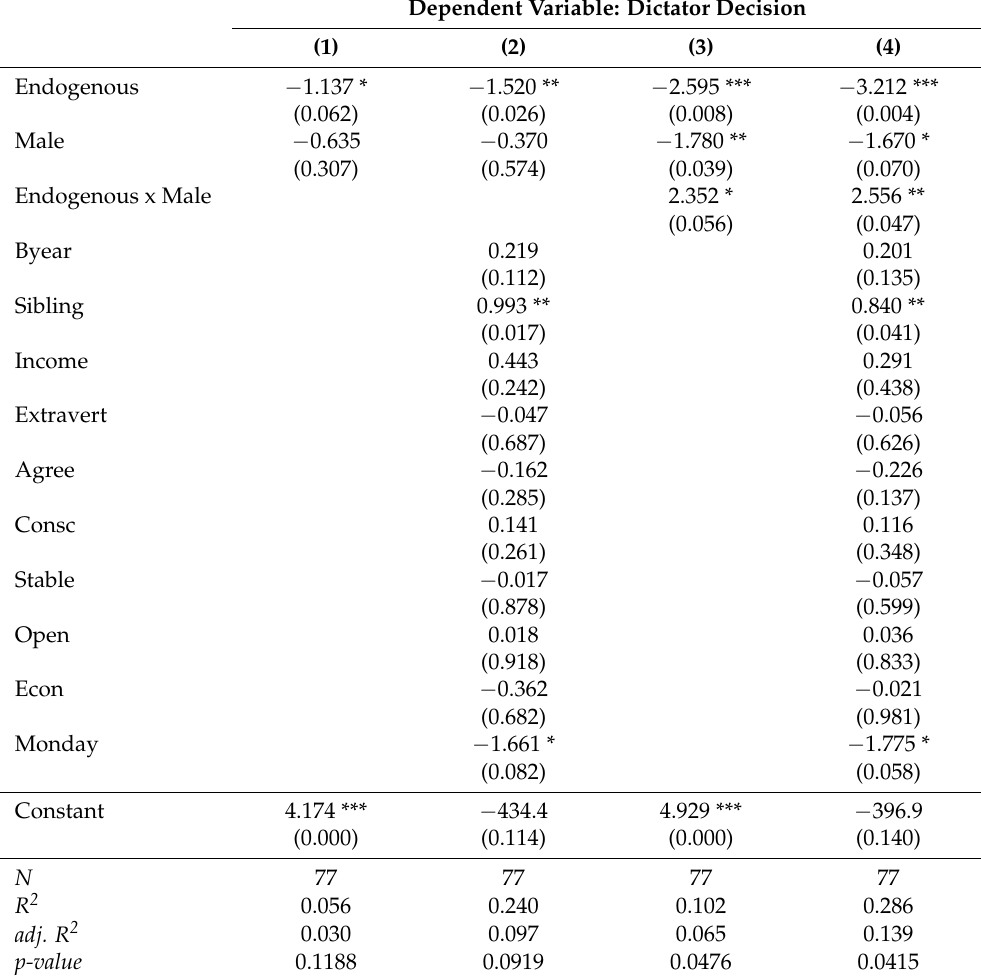
Table 3. OLS results for dictator